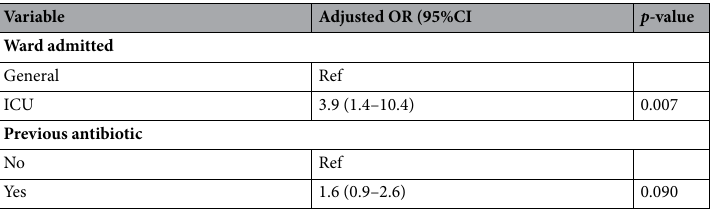
Table 5. Multivariable analysis of factor associated with carriage of Extended-spectrum beta-lactamase (ESBL) producing Enterobacteriaceae (EPE) in feces at admission. Odds ratio adjusted for age in months and